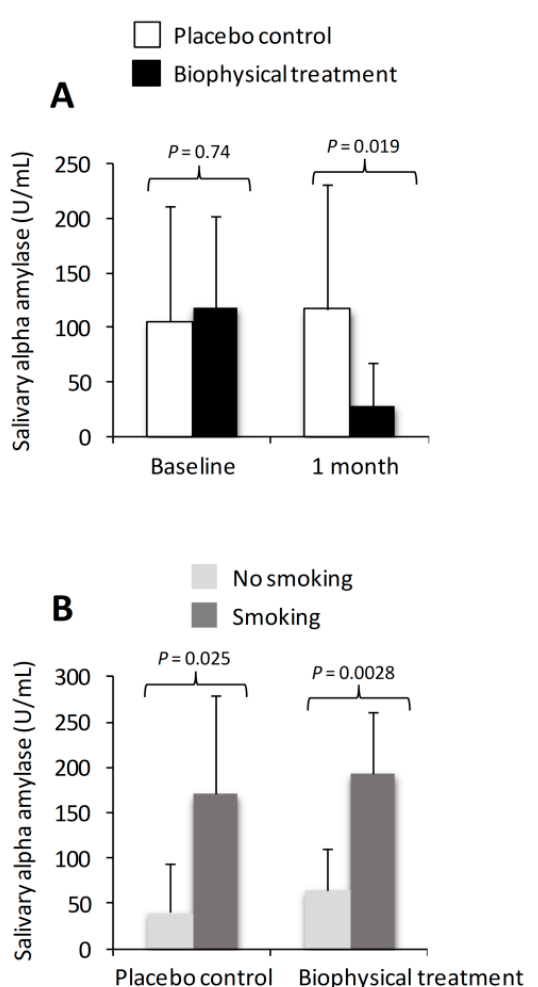
biophysical groups (Figure 1B). Age and gender were not observed to influence SAA levels at baseline or follow up.